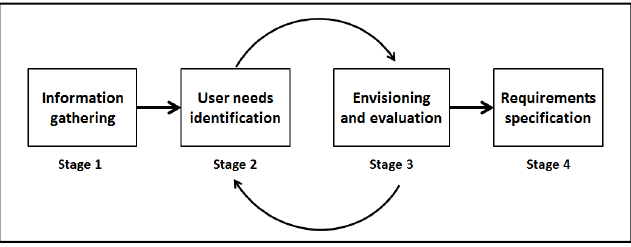
Figure 4. General process for users’ requirements analysis. Source: Adapted from [14].